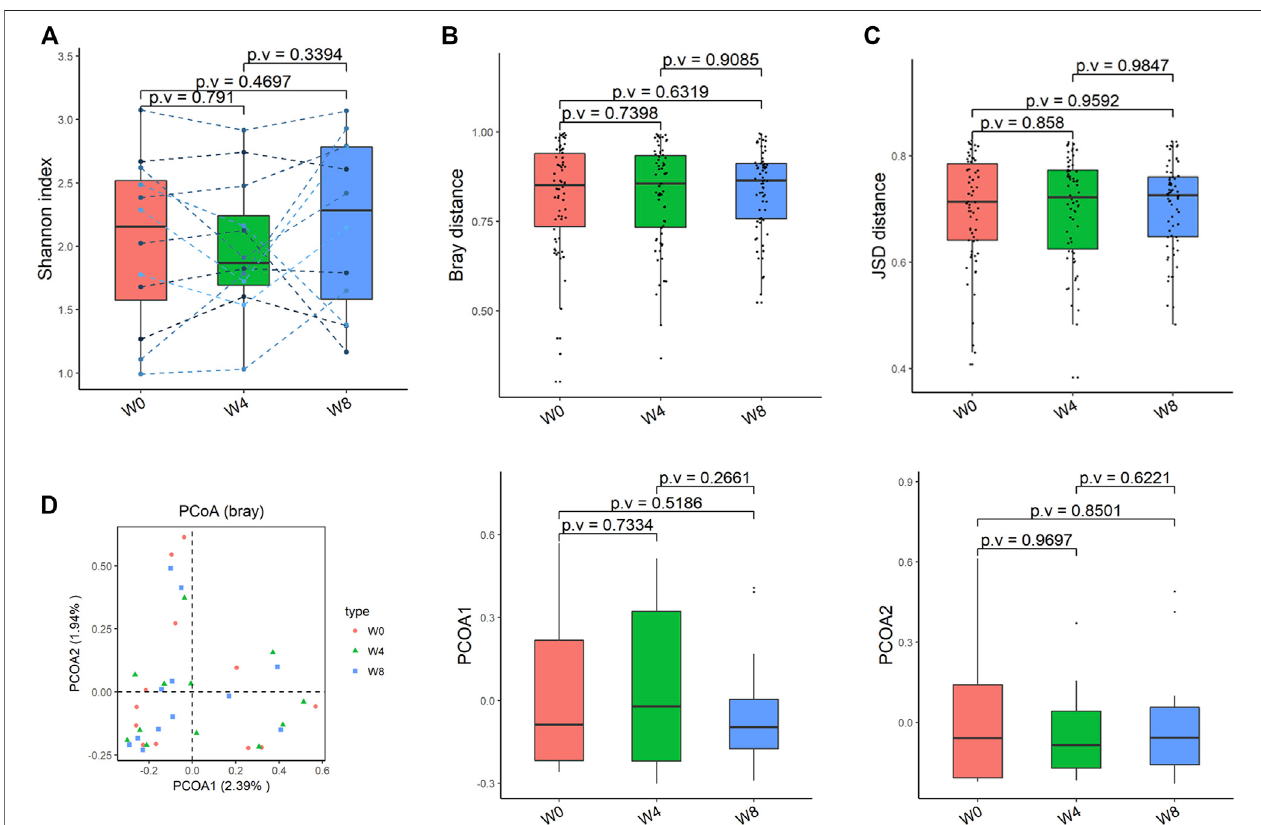
FIGURE 4 | Alpha-diversity, beta-diversity, and principal component analysis at the strain level. (A) Shannon index was not signi fi cantly different in comparisons betweenW0andW4,W0andW8,andW4andW8. (B) Nosigni fi cantdifferenceinbetadiversitybasedonBray-Curtis(Bray)distanceforW0vsW4,W0vsW8,andW4 vs W8. (C) The Jensen-Shannon Divergence (JSD) distance-based beta diversity was not signi fi cantly different in W0 vs W4, W0 vs W8, and W4 vs W8. (D) PCoA analysis based on Bray distance showed that the fi rst principal component was not signi fi cantly different in W0 vs W4, W0 vs W8, and W4 vs W8, nor the second